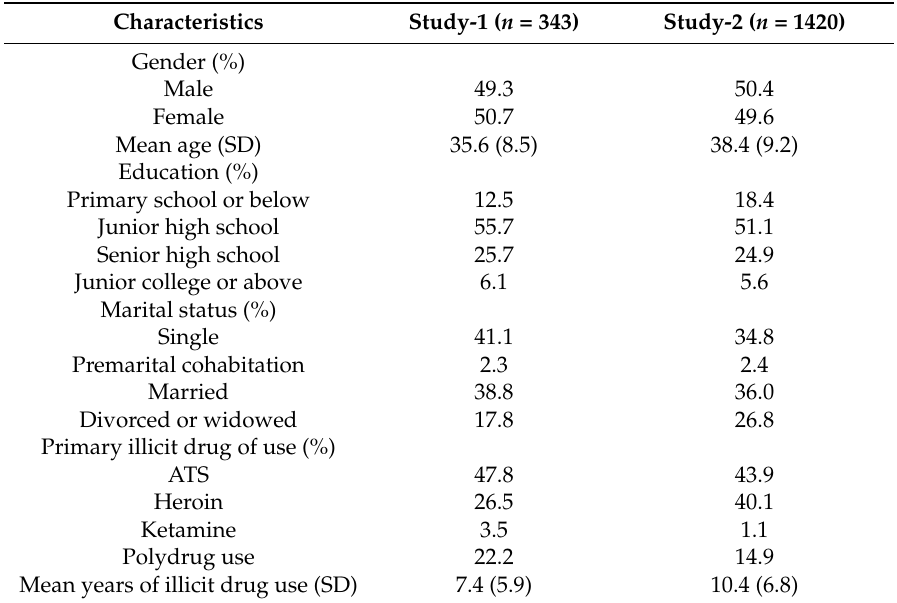
Table 1. Characteristics of the